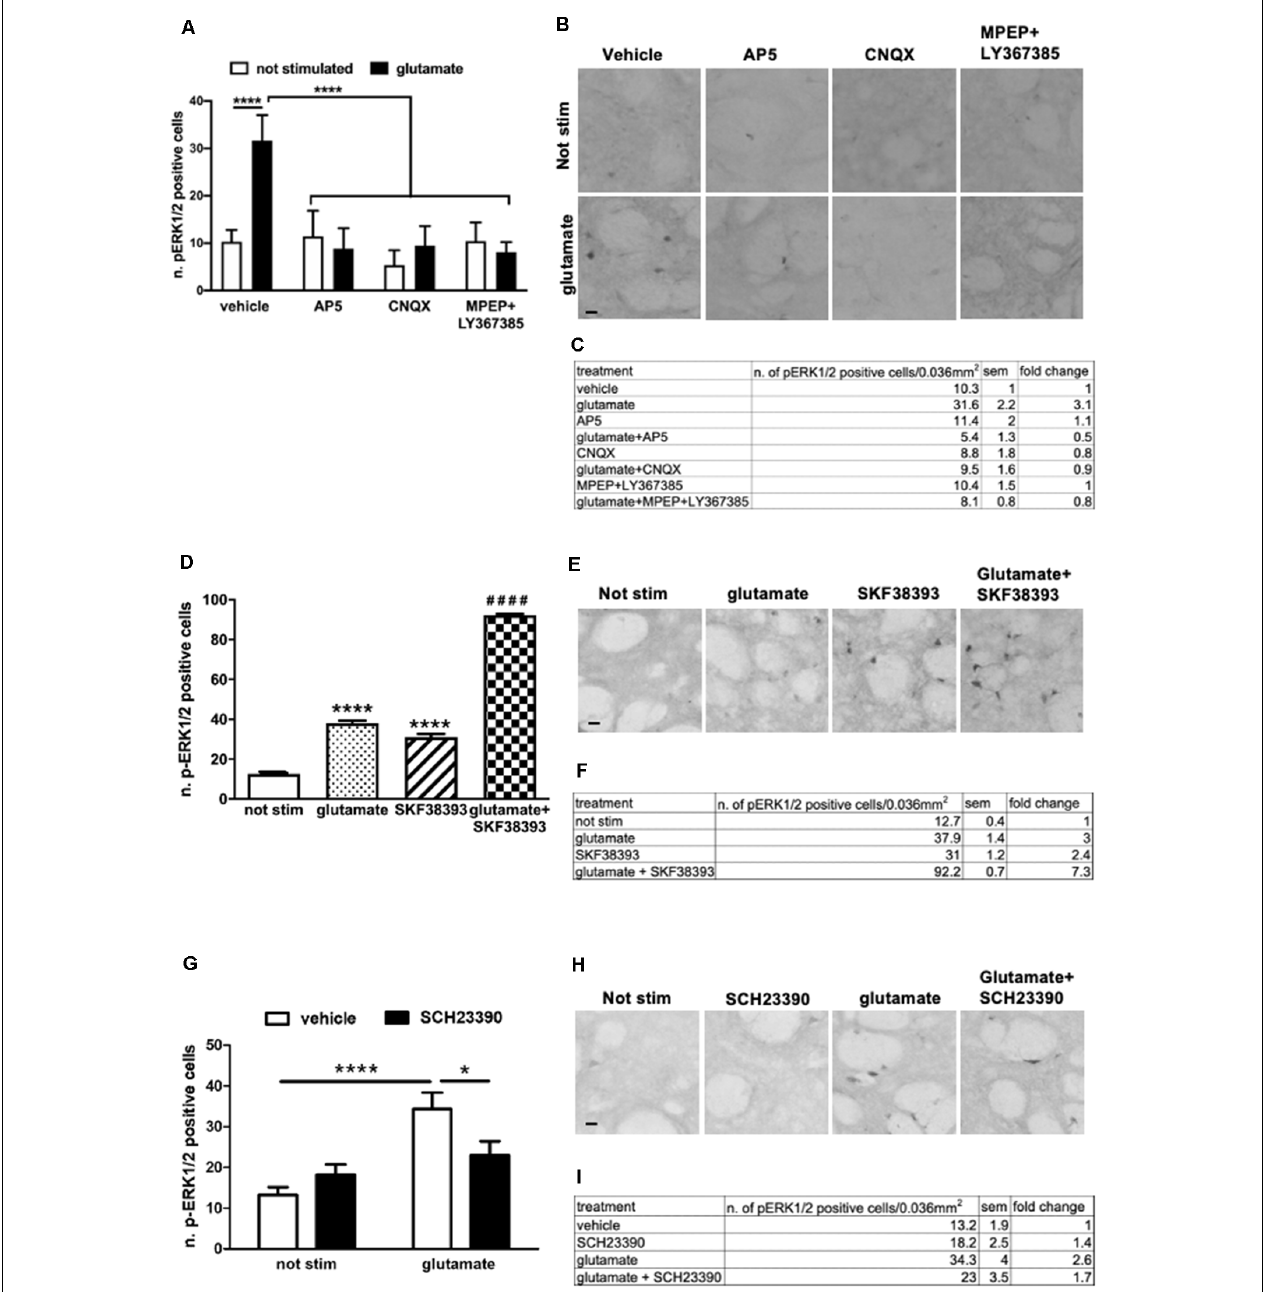
FIGURE 3 | (A,C) Pre-treatment with AP5 10 µ M, CNQX 10 µ M or with a mix of MPEP 20 µ M and LY367385 100 µ M completely prevents glutamate-induced ERK activation (two-way ANOVA, effect of glutamate F (1,43) = 20.74, p < 0.0001, effect of inhibitors F (3,43) = 28.08, p < 0.0001, effect of interaction F (3,43) = 24.24, p < 0.0001. Bonferroni’s post hoc , not stimulated vs. glutamate **** p < 0.0001, AP5 + glu vs. glu **** p < 0.0001, CNQX + glu vs. glu **** p < 0.0001, MPEP + Ly367385 + glu vs. glu **** p < 0.0001). The values of mean, SEM and fold change relative to not stimulated vehicle are shown in panel (C) . Data are shown as mean ± SEM. (B) Representative pictures of anti-phospho-ERK1/2 immunohistochemistry. Scale bar: 50 µ m. (D,F) Slices co-stimulated with SKF38393 10 µ M and glutamate 10 µ M show increased levels of phospho-ERK1/2 in comparison with those stimulated with SKF38393 10 µ M or glutamate 10 µ M (two-way ANOVA, effect of glutamate F (1,24) = 1759.699 p < 0.0001, effect of SKF38393 F (1,24) = 1247.512, p < 0.0001, effect of interaction F (1,24) = 305.606, p < 0.0001. Bonferroni’s post hoc , not stimulated vs. glutamate: **** p < 0.0001, not stimulated vs. SKF38393: **** p < 0.0001, SKF38393 vs. SKF38393 + glutamate: #### p < 0.0001, glutamate vs. SKF38393 + glutamate: #### p < 0.0001). Data are shown as mean ± SEM. The values of mean, SEM and fold change relative to not stimulated control are shown in panel (F) . Not stimulated: n = 8, glutamate: n = 6, SKF38393: n = 6, SKF38393 + glutamate: n = 8. (E) Representative pictures of anti-phospho-ERK1/2 immunohistochemistry. Scale bar: 50 µ m. (G,I) Pre-treatment with the D1 antagonist SCH23390 20 µ M prevents glutamate-induced ERK